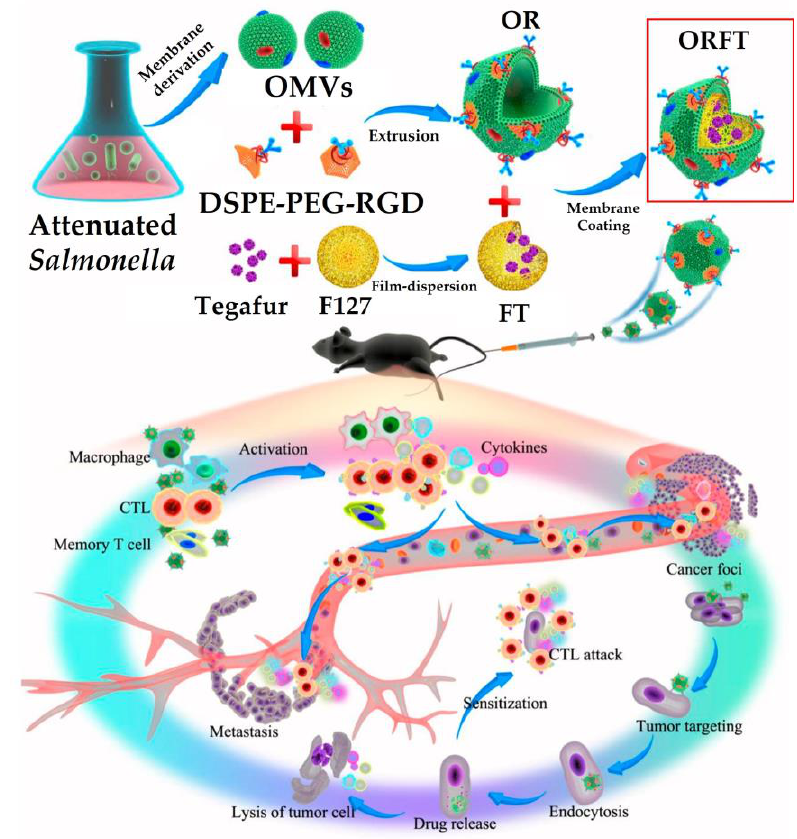
Figure 4. Schematic of the functionalized OMV-coated polymeric micelles for anticancer application. First, OMVs were collected from attenuated Salmonella and fused with non-fouling polyethylene glycol-PEG (DSPE-PEG) and tumor-targeting ligand Arg-Gly-Asp (RGD) through the extrusion of OMVs and DSPE-PEG-RGD to generate OMV-DSPE-PEG-RGD (OR). OR was further used to coat tegafur-loaded micelles (FT) and to obtain OR-coated F127 nanomicelles (ORFT; red box). Later, melanoma-bearing mice was intravenously injected with ORFT nanoparticles, which generate antitumoral response by OMVs and kill cancer cells directly through tegafur. Reproduced with permission from Ref. [10], copyright American Chemical Society.